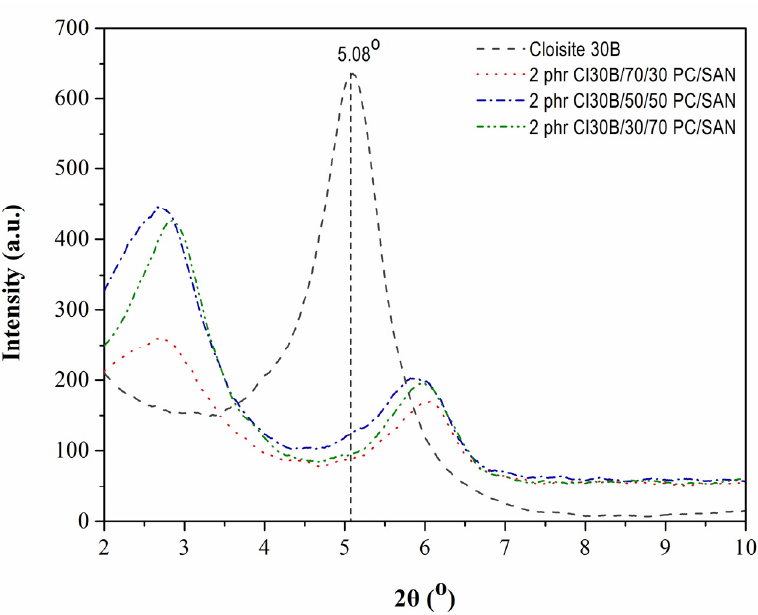
Figure 2. XRD patterns of Cloisite 30B and 2 phr Cloisite 30B/PC/SAN blend nanocomposites.